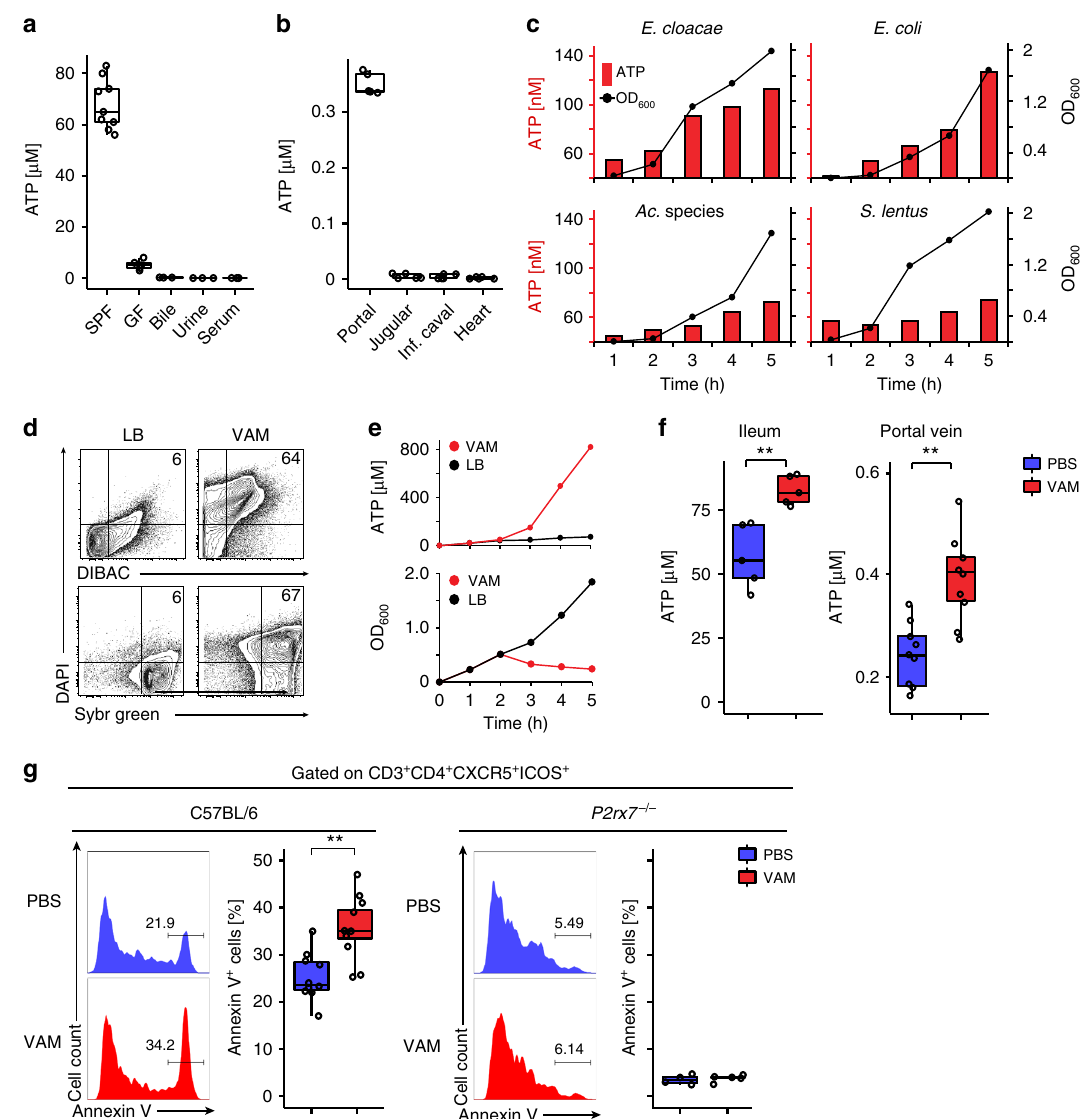
Fig. 1 Bacterial origin of intestinal ATP. a ATP concentration in the lumen of ileum from SPF and GF mice, bile, urine, and serum from SPF mice. b ATP concentration in serum from portal, jugular, inferior caval veins, and heart. c ATP concentrations in culture medium (bars) and cell growth (OD 600 ) of the indicated bacterial species isolated from the small intestine of SPF mice. d Flow cytometry of ileal bacteria either maintained in culture medium (LB) or treated with VAM, for membrane damage (DIBAC + DAPI + cells, upper dot plots) and cell death (SybrGren + DAPI + cells, lower dot plots). e ATP concentrations (upper panel) and ileal bacteria growth (lower panel) in untreated (LB) and VAM-treated cultures. f ATP concentration in ileum and portal vein of SPF mice at 3 h after orogastric gavage with PBS or VAM. g Representative histograms and statistical analysis of Annexin V + cells within Tfh cells from PPs of WT (C57BL/6) and P2rx7 − / − mice at 3 h after gavage with PBS or VAM. The boxplots show median and upper and lower quartiles. The extreme lines show the highest and lowest value. The boxplot is overlaid with the visualization of single observations. Two-tailed Mann – Whitney U -tests. ** p < 0.01. One representative experiment out of at least three is